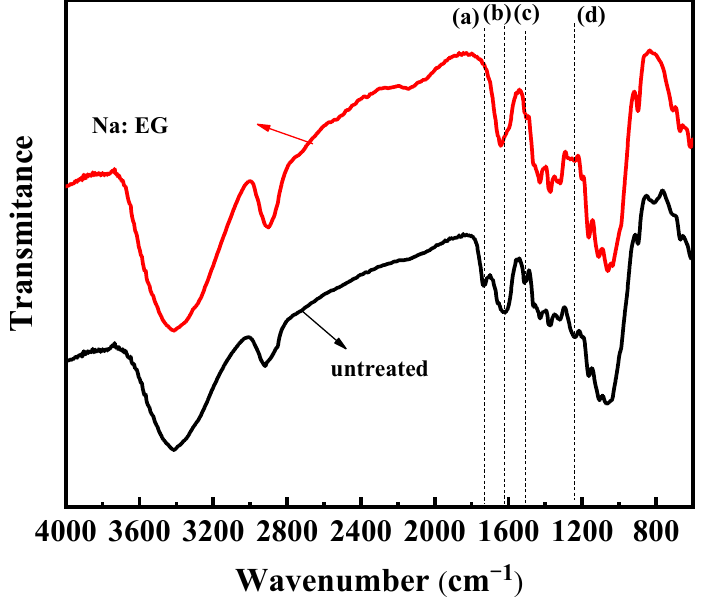
Figure 11. FT-IR spectra of untreated wheat straw and Na:EG-treated residue: (a) 1735 cm − 1 , (b) 1618 cm − 1 , (c) 1512 cm − 1 , and (d) − 1242 cm − 1 .